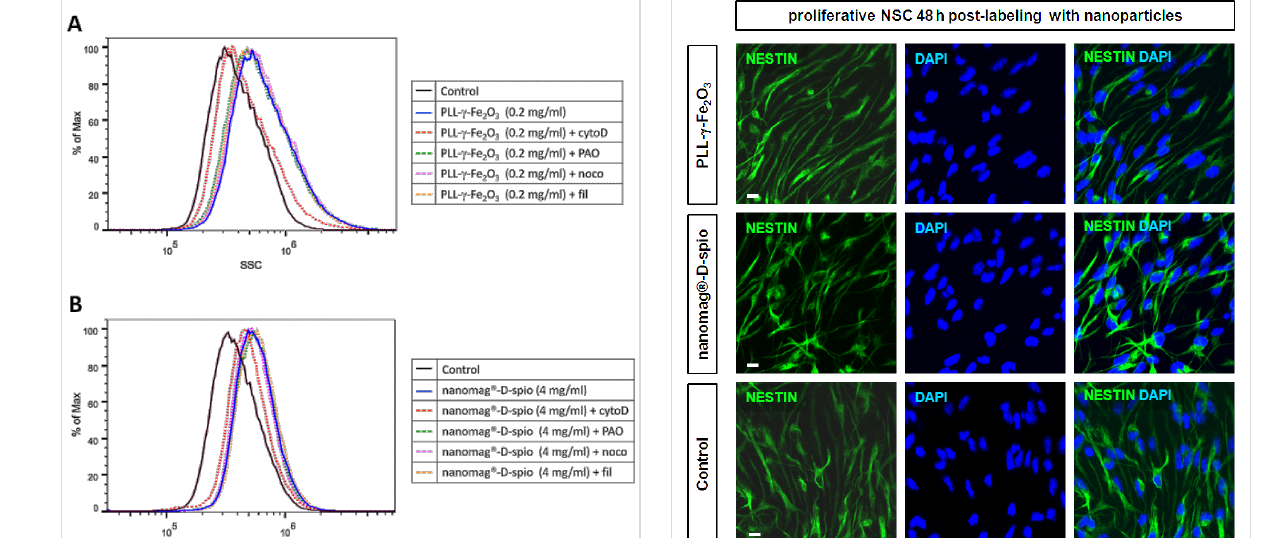
(Figure 8), suggesting they maintain their phenotype as neural progenitor cells. NSCs spontaneously differentiate into neurons, astrocytes and oligodendrocytes when cultured in the absence of growth factors FGF and EGF. Both PLL- γ -Fe 2 O 3 - and